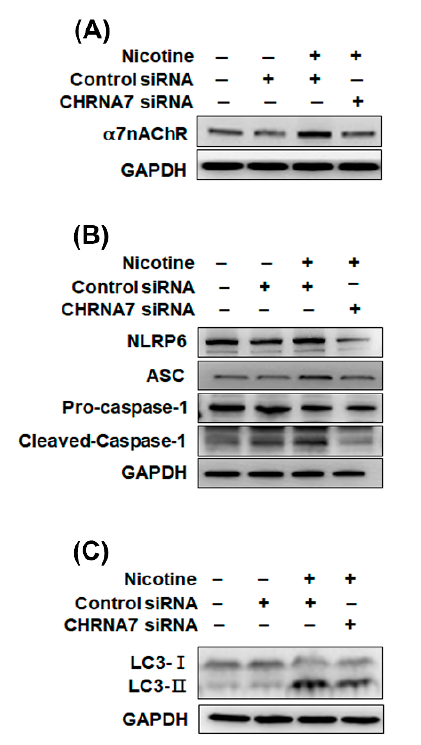
Figure 5. Nicotine induced NLRP6 inflammasomes and autophagy via α 7nAChR regulation. ( A ) Western blotting for α 7nAChR protein in HK-2 cells treated with control siRNA or CHRNA7 siRNA. ( B ) Western blot analysis of NLRP6 inflammasome-associated protein expression in HK-2 cells. ( C ) The protein levels of LC3 in HK-2 cells. The cells were transfected with control or CHRNA7 siRNA for 24 h and then were treated with nicotine (100 µ M) for 24 h. The plus signs indicated to add the nicotine, control siRNA or CHRNA7 siRNA. The minus signs indicated without the nicotine, control siRNA or CHRNA7